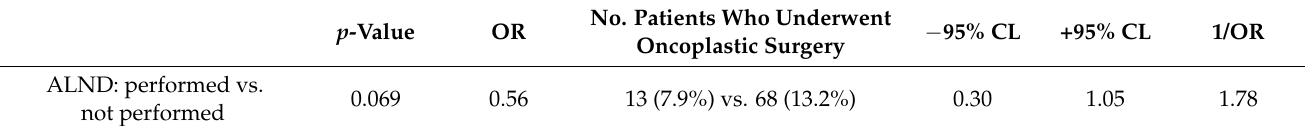
Table 5. The multivariate regression analysis on the performed oncoplastic surgery and the applied treatment.